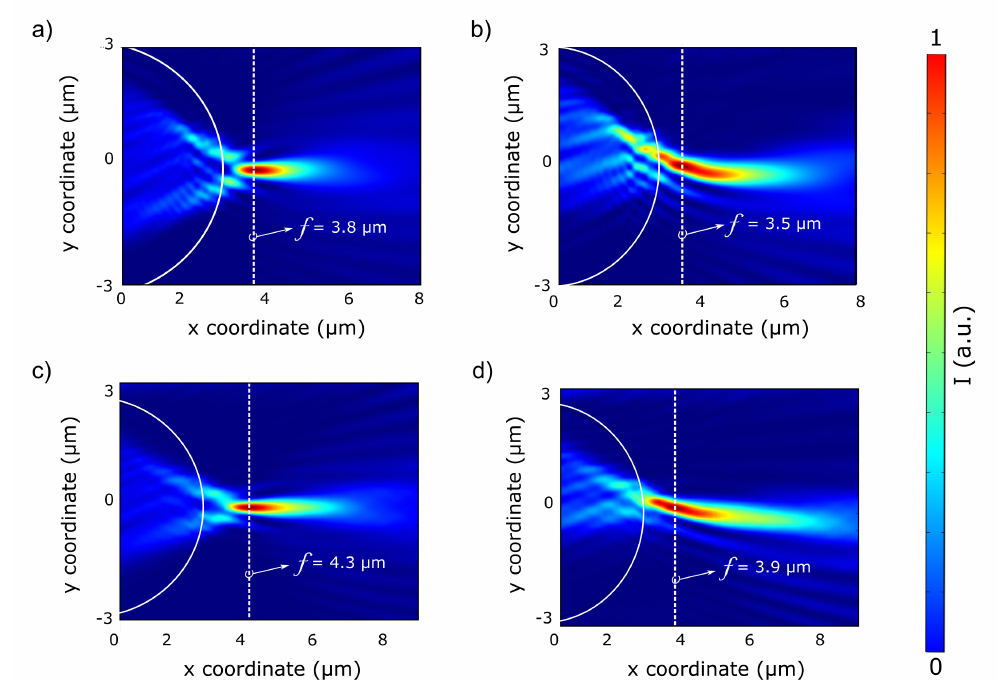
Figure 4. Normalized distribution of the Poynting vector S x via a 6 µ m diameter silica microcylinder illuminated by a 637 nm continuous plane-wave in the x -direction. Solid white lines represent the microcylinder boundary and dashed white lines represent the focal point f . ( a ) PNJ formation in air. ( b ) PH formation in air. The mask blocks 25% of the illuminating light. ( c ) PNJ formation in water while the cylliner is illuminated from the air. ( d ) PNJ formation in water while light is illuminated from the air and the mask blocks 25% of the illuminating